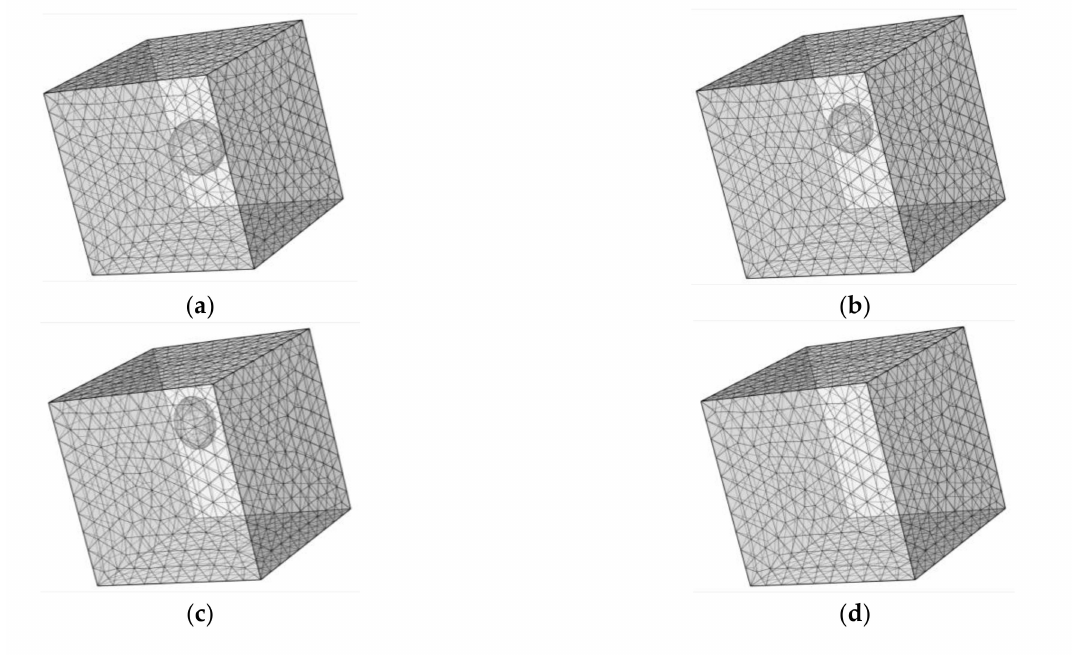
Figure 13. ( a ) Mesh grid of CFEM at 0 s; ( b ) Mesh grid of CFEM at 0.025 s; ( c ) Mesh grid of CFEM at 0.035 s; ( d ) Mesh grid of XFEM for all times.